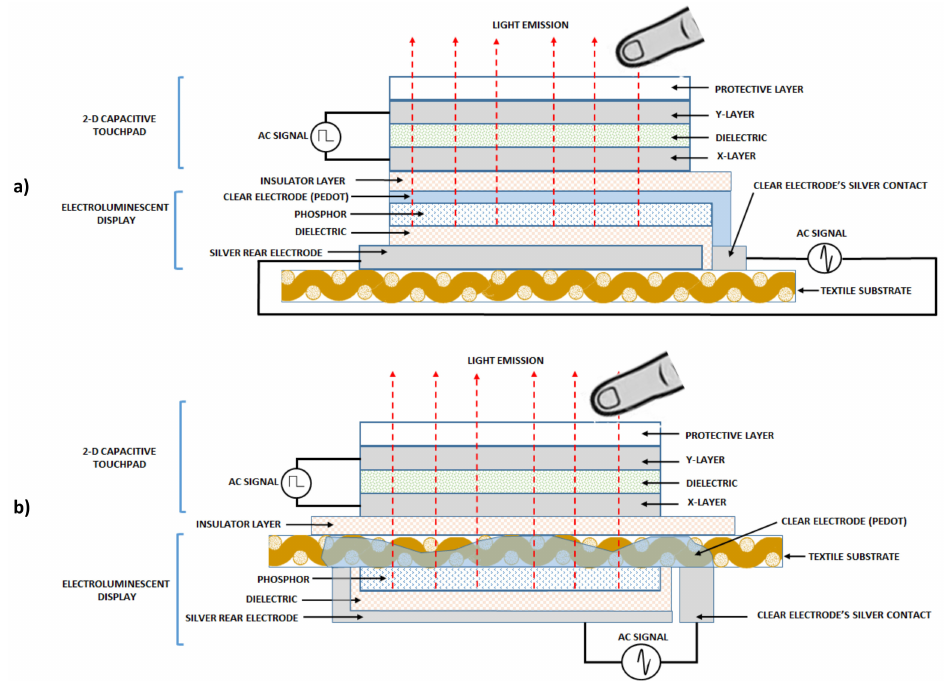
Figure 1. ELD + 2D touchpad architecture: All the design on one side of the textile ( a ); Using the textile itself as a separating element, on one side the ELD and on the other one the 2D touchpad sensor ( b ). ELD: electroluminescent